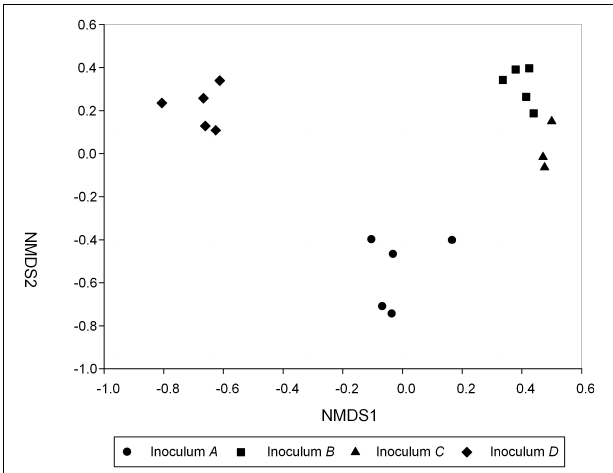
FIGURE 1 | Soil AMF community structure under four inocula. Non-metric multidimensional scaling (NMDS) illustrates the differences in AMF communities for different inocula obtained from C. korshinskii (Inoculum A), H. leave (Inoculum B), C. microphylla (Inoculum C), and P. annua (Inoculum D) plants after trap culture. The value of stress was 0.038. Note that two samples of inoculum C were discarded due to low sequencing